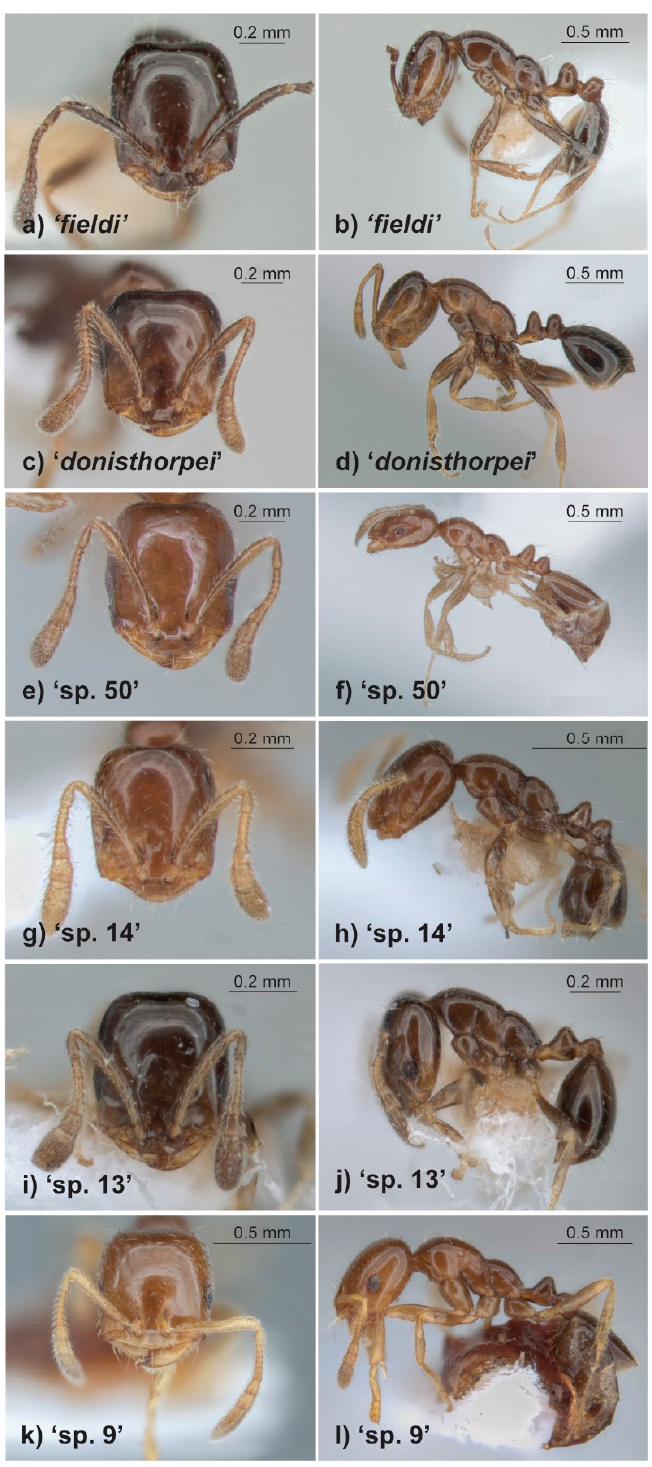
Figure 2. Images of the six general morphotypes of species within the Monomorium nigrius group. ( a , b ) ‘fieldi’ (sequenced specimen ID OZBOL4003-21; species A15); ( c , d ) ‘donisthorpei’ (OZBOL4454-21; species C3); ( e , f ) ‘sp. 50’ (MONO197-16; species B19); ( g , h ) ‘sp. 14’ (OZBOL4460-21; species G6); ( i , j ) ‘sp. 13’ (OZBOL4013-21; species H9); ( k , l ) ‘sp. 9’ (not sequenced, collected from the Territory Wildlife Park, near Darwin, NT; species L). The different morphotypes commonly occur in close sympatry; indeed, nine species shown to be differentiated genetically and morphologically, and representing all six mor- photypes, have been recorded from a savanna woodland site (Territory Wildlife Park)